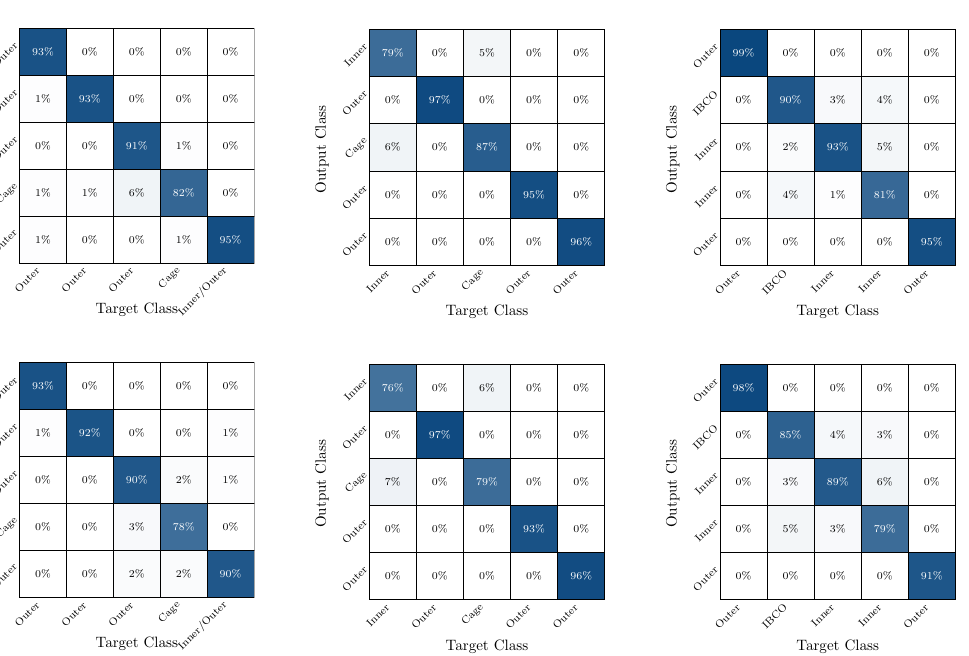
Figure 9. Analysis of sorted weights for FC and convolutional layers from pruned AE and AlexNet model respectively after retraining. ( a ) Sorted average weights from two FC layers from pruned AE model; ( b ) Weights from five convolutional layers from pruned AlexNet model. The confusion matrix from the original and pruned model predictions are shown in Figure 10 for LeNet. We chose to highlight the confusion matrix only for one model with CWT features, the results are however similar for all other combinations. There are three different types of bearing usage and each type has five bearing defects. In the figures showing confusion matrix, the three columns represent the three different bearing usage types. The first row of sub figures in Figure 10 are the results from the original models while the second row of confusion matrices are from pruned models for the same features.